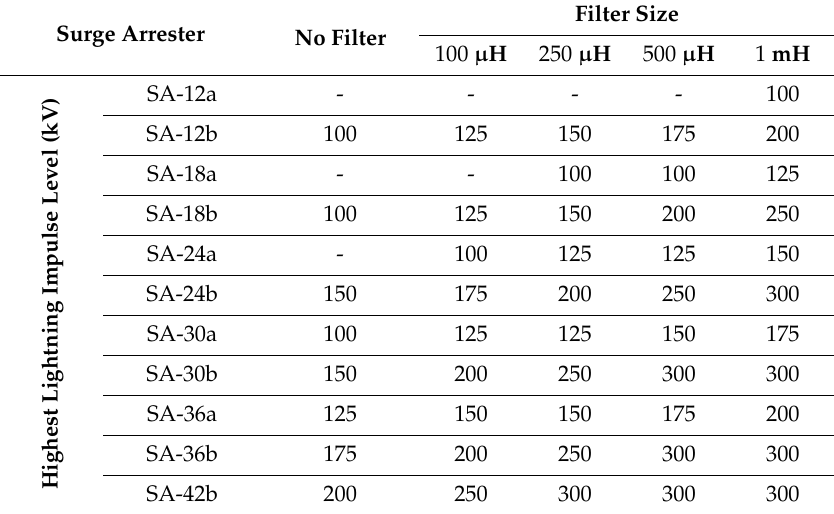
Table 3. Performance of surge arrester and filtered surge arrester under indirect lightning